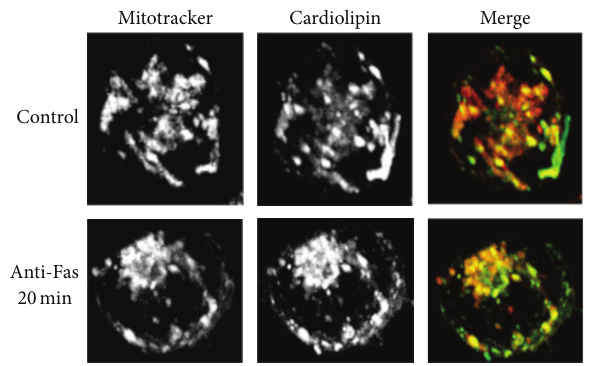
Figure 1: Cardiolipin-mitochondria association following apoptotic triggering. T cells, untreated or treated with anti-CD95/Fas for 20 min, were stained with MCL-BODIPY, a green fluorescent analogue of CL [30, 31], and then with 50 nM Mitotracker red. Projected images from 33 z-sections of 0.2 nm, obtained after 10 cycles of deconvolution, were acquired by using a state-of-the-art Deltavision RT